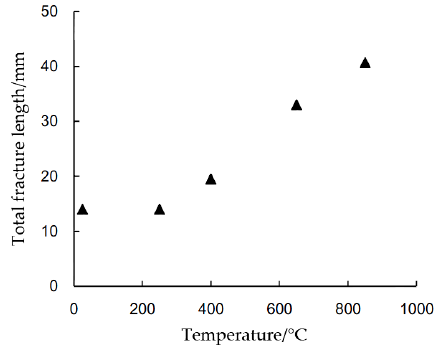
Figure 16. Total length of the propagation fracture varies with temperature [28]. Fig. 14 Ultimate failure mode of granite specimens after heating treatment (Shao, 2015)